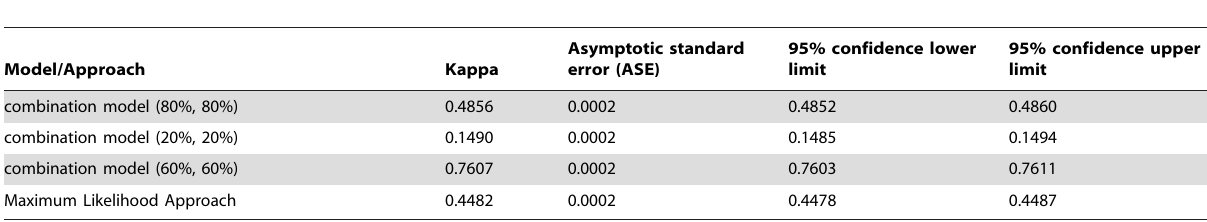
Table 7. Comparison of the Z values in each